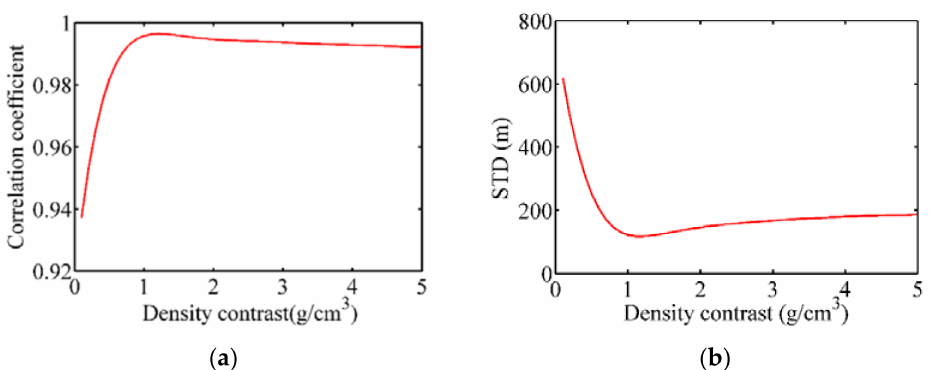
Figure 7. Parameter selection of density contrast. ( a ) Correlation coefficient curve. ( b ) Standard deviation